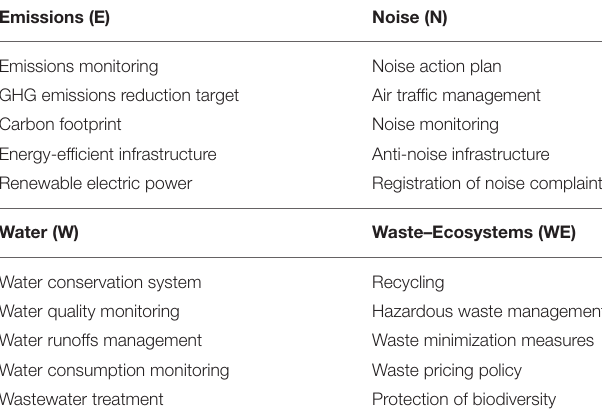
TABLE 1 | Environmental performance evaluation criteria.